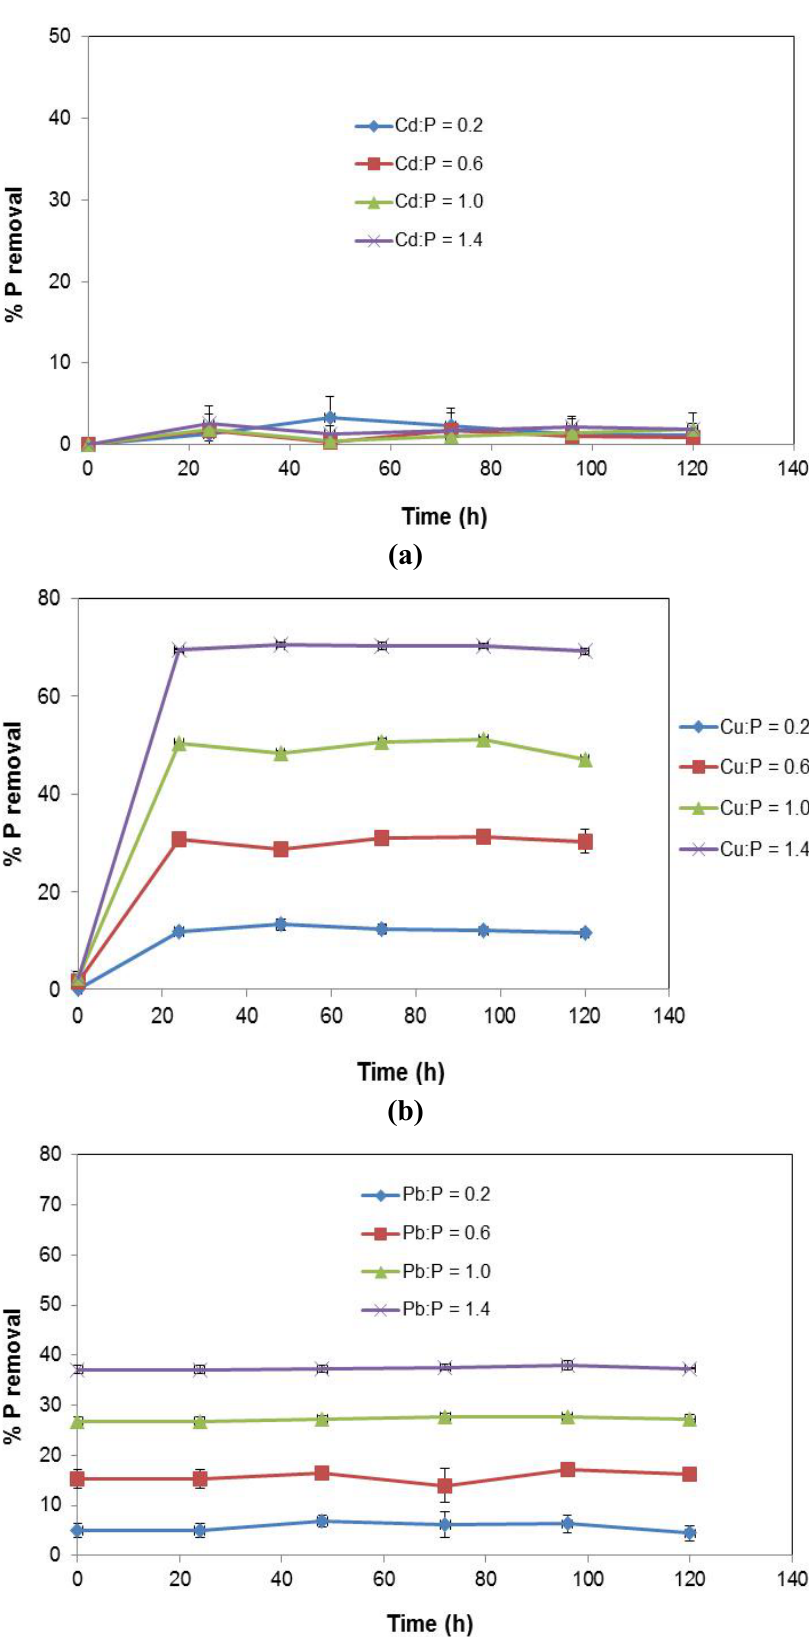
Figure 4. Precipitation patterns of metal ions of increasing concentration reacting with P in the stormwater systems (no slag) ( a ) P + Cd; ( b ) P + Cu; ( c ) P + Pb; ( d ) P +